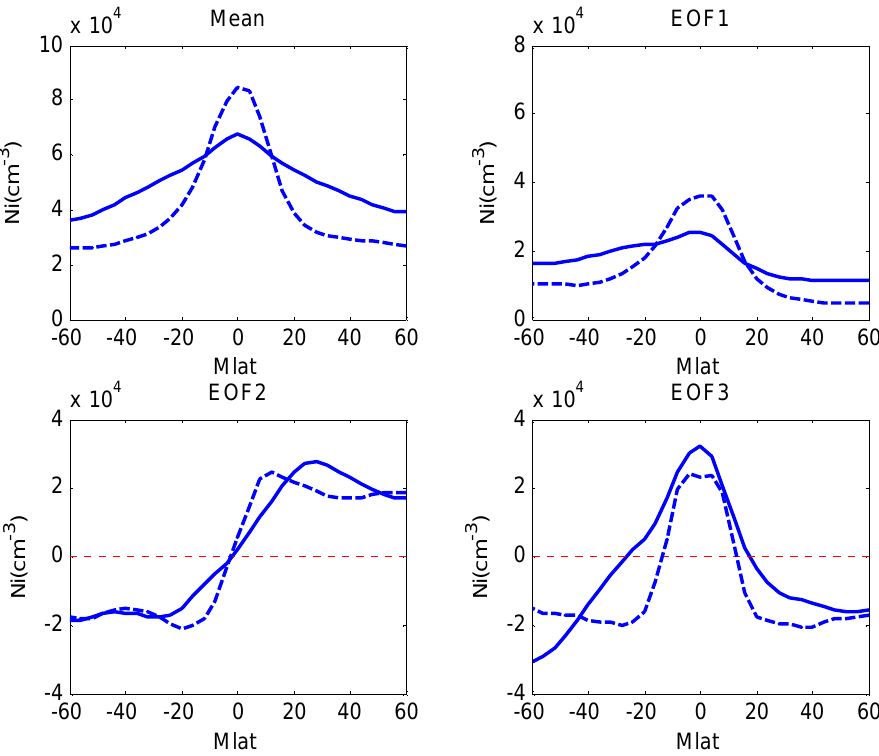
Figure 3. Mean ion density and first three empirical orthogonal functions derived from the DMSP data set. Solid line represents the value at 0930 LT and dashed lines represent that at 2130 LT.